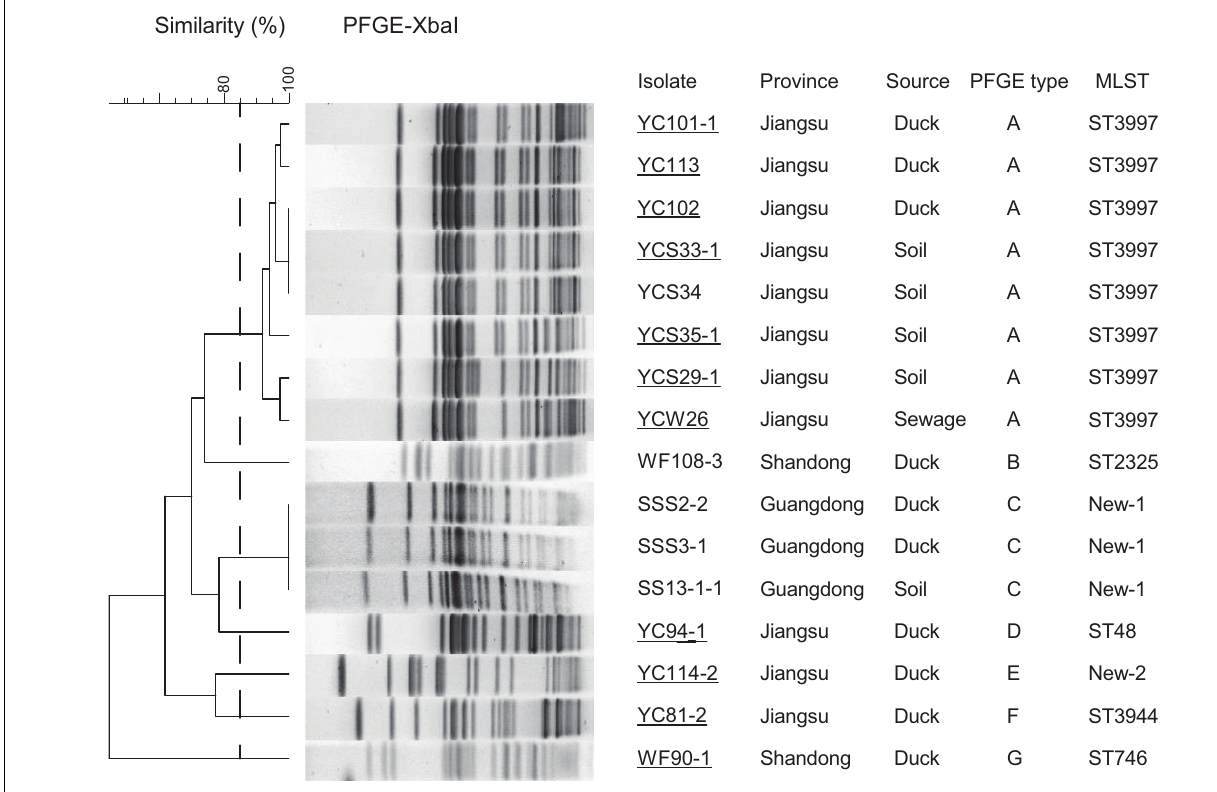
FIGURE 3 | PFGE-X bal dendrogram and details about tet (X4)-positive E. coli isolates, PFGE patterns with a cutoff at 85% similarity were considered to be the same cluster and are included as groups A–G. Sampling details are listed in the right table, as well as the MLST analysis results of WGS. Conjugation assays to C600 succeeded for 11 isolates labeling with underline. Duck, duck